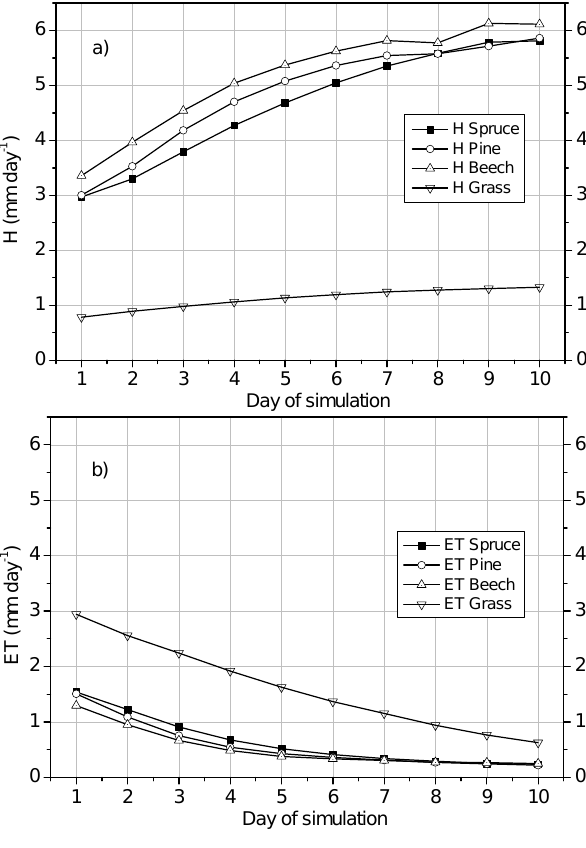
Fig. 12. Daily sum of sensible heat flux (a) and evapotranspiration (b) during a summery dry period. HIRVAC simulations for spruce, pine and beech with the stand parameters: height=30m, LAI=5, crown cover=70%, as well as for grass with height=0.15m, LAI=4, fraction of